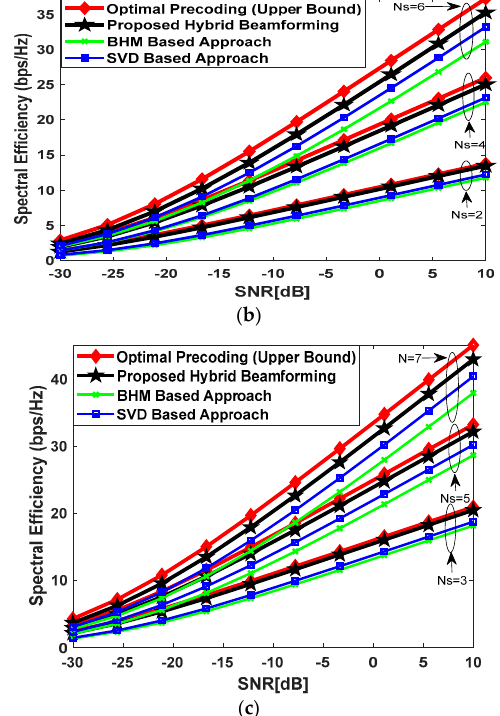
Figure 2. ( a ) Spectral efficiency achieved by different relay selection techniques when 𝑁 (cid:3047) (cid:3404) 𝑁 (cid:3045)(cid:3032)(cid:3039) (cid:3404) 100,𝑁 (cid:3045) (cid:3404) 36,𝑁 (cid:3046) (cid:3404) 2,3,4 with UPA at all communicating nodes. Mm ‐ Wave channel matrix is generated by assuming 𝑁 (cid:3030)(cid:3039) (cid:3404) 4,𝑁 (cid:3045)(cid:3028)(cid:3052) (cid:3404) 10 and 10 (cid:3042) spread angle. The number of RF ‐ chains is equal to the number of data streams. It is assumed that 10 relay nodes are available between the source and the destination for the selection of the best relay; ( b ) spectral efficiency achieved by different relay selection techniques when 𝑁 (cid:3047) (cid:3404) 𝑁 (cid:3045)(cid:3032)(cid:3039) (cid:3404) 144,𝑁 (cid:3045) (cid:3404) 36,𝑁 (cid:3046) (cid:3404) 3,4,5 with UPA at all communicating nodes. Mm ‐ Wave channel matrix is generated by assuming 𝑁 (cid:3030)(cid:3039) (cid:3404) 4,𝑁 (cid:3045)(cid:3028)(cid:3052) (cid:3404) 10 and a 10 (cid:3042) spread angle. It is assumed that the number of RF ‐ chains is equal to the number of data streams, and 10 relay nodes are present between the source and the destination for the selection of the best relay; ( c ) spectral efficiency achieved by different relay selection techniques when 𝑁 (cid:3047) (cid:3404) 𝑁 (cid:3045)(cid:3032)(cid:3039) (cid:3404) 256,𝑁 (cid:3045) (cid:3404) 64,𝑁 (cid:3046) (cid:3404) 5,6,7 with UPA at all communicating nodes. Mm ‐ Wave channel matrix is generated by assuming 𝑁 (cid:3030)(cid:3039) (cid:3404) 4,𝑁 (cid:3045)(cid:3028)(cid:3052) (cid:3404) 10, and a 10 (cid:3042) spread angle. It is assumed that the number of RF ‐ chains is equal to the number of data streams, and 10 relay nodes are present between the source and the destination for the selection of the best